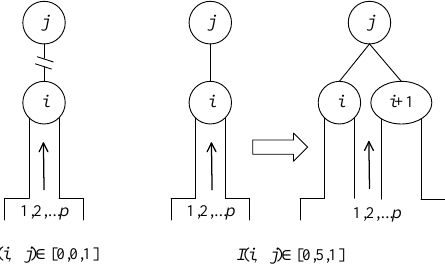
Figure 6. Division or disconnection of neuron I.